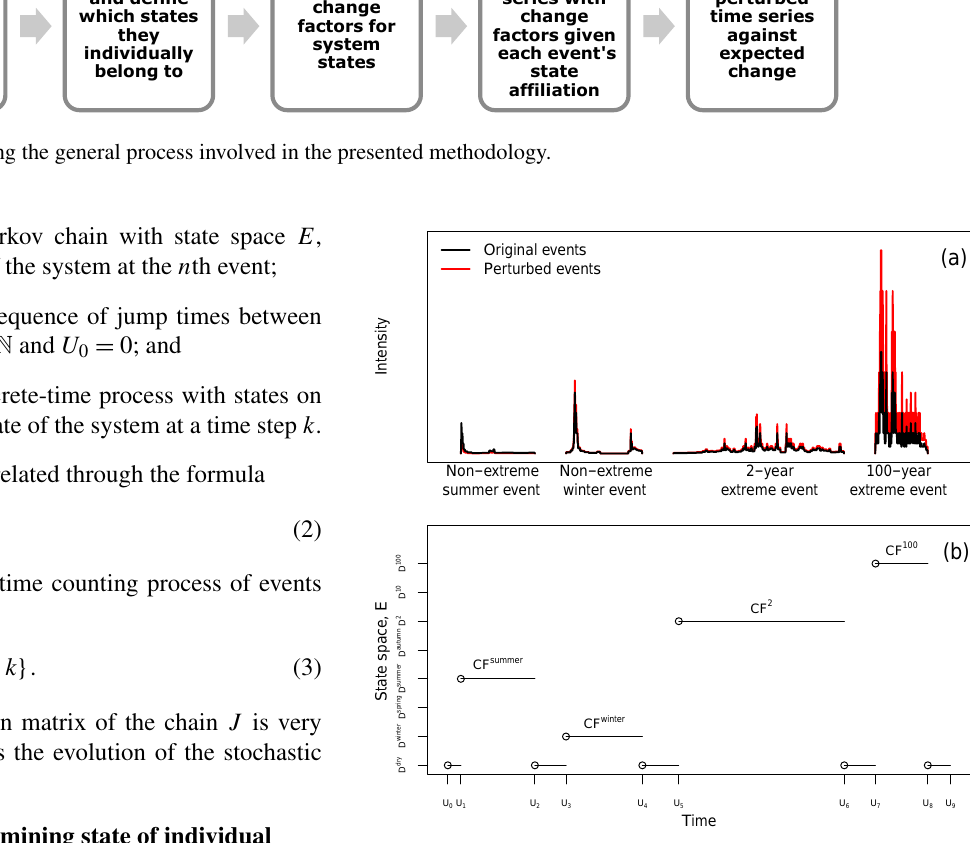
Figure 2. (a) Illustration of the magnitude of perturbation of events for non-extreme summer and winter events as well as 2- and 100- year extreme events, with summer events being perturbed with a factor below 1 and factors for the winter and the extremes being above 1. Factors for extremes are higher than for the winter events, and factors for the very extreme are higher than for the more mod- erate extreme. (b) Illustration of the states associated with the dif- ferent events if they were to happen in the shown chronology; the dry state, D dry , is present between all wet